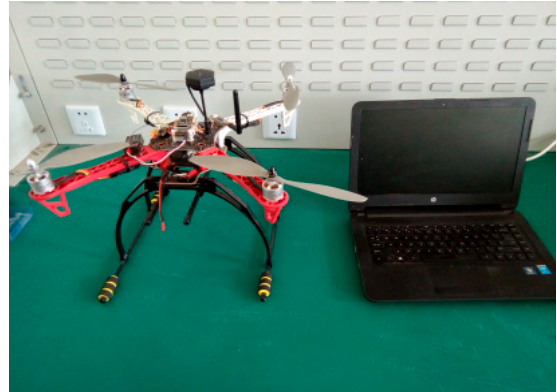
Figure 5. The quadrotor used in the experiments. Algorithms 2018 , 11 , x FOR PEER REVIEW